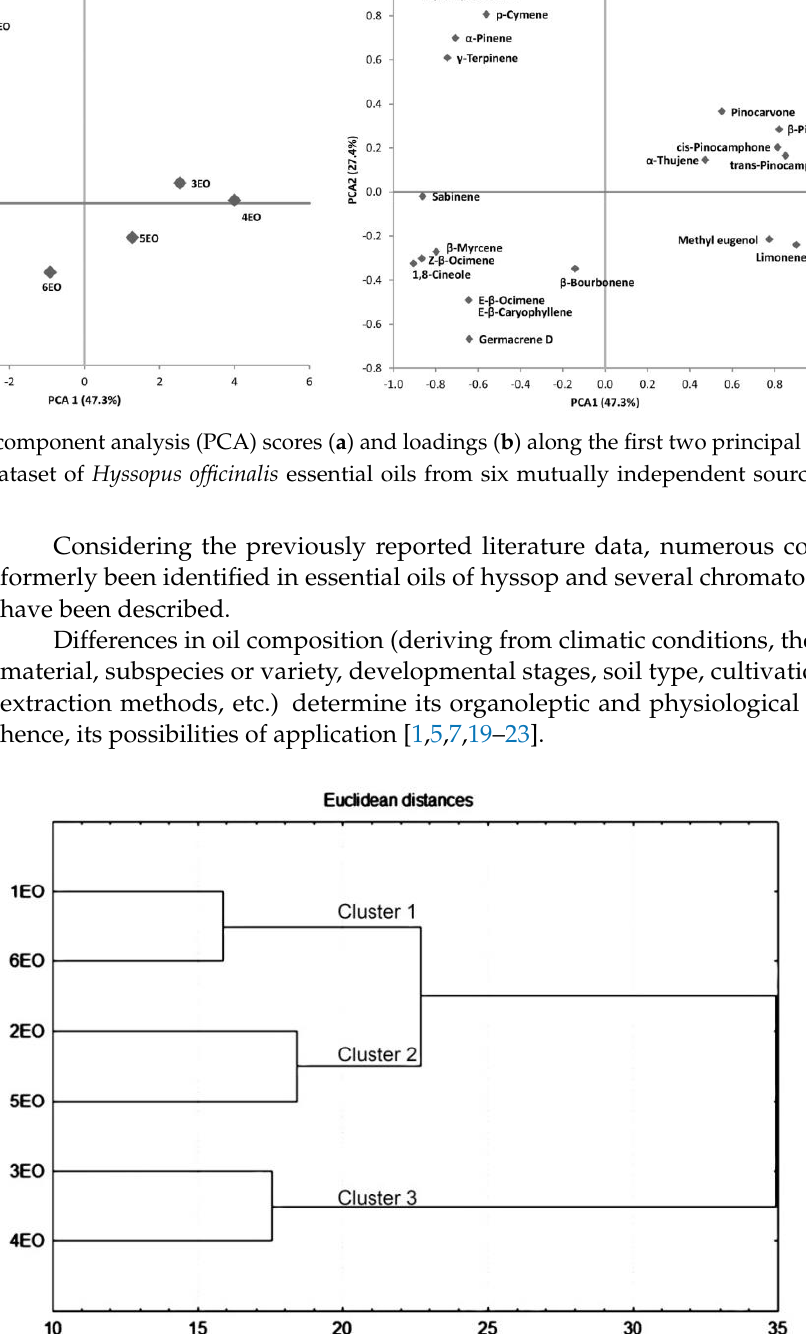
Figure 2. Dendrogram representing the similarity relations of the chemical composition of Hys- sopus officinalis essential oils. For this analysis, an entire chromatographic dataset was taken into consideration. Amalgamation rule: single-linkage. Distance metric is Euclidean distances (non- standardized). The most characteristic and important components of so far investigated H. officinalis essential oils are 1,8-cineole [1,21,22], cis -pinocamphone, trans -pinocamphone and their precursor β -pinene [1,19]. Among the other principal constituents, pinocarvone, sabinene, germacrene D, germacren D-4-ol, α -, β -phellandrene, 4-carvomenthenol, thymol,